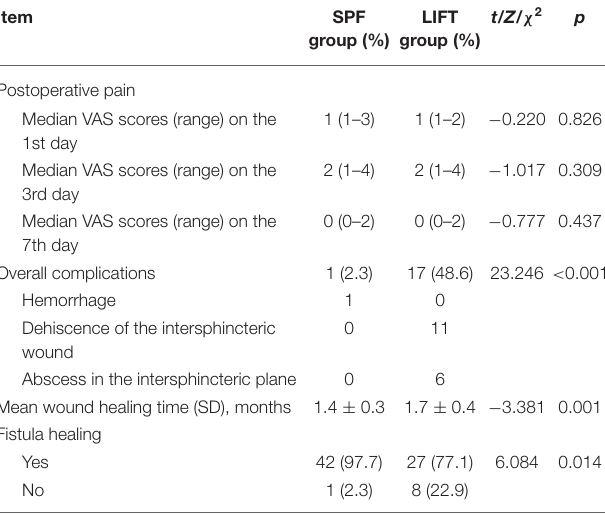
TABLE 2 | Clinical outcomes after surgery.